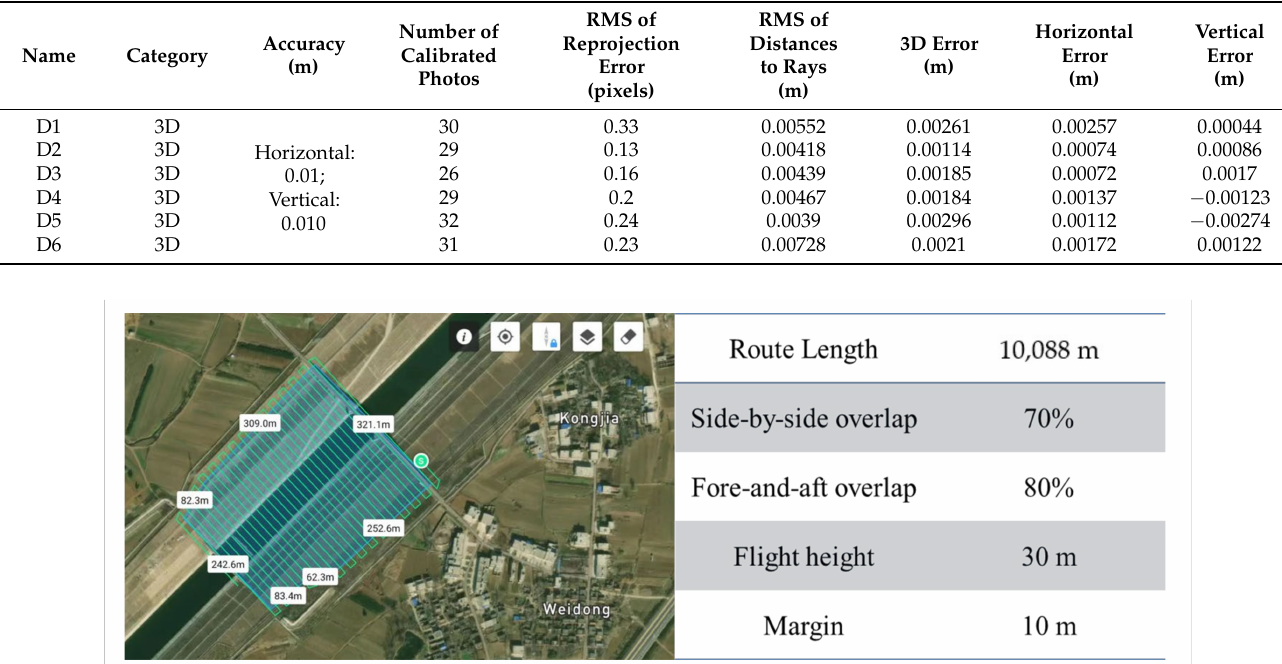
Figure 4. UAV route planning and basic parameter-setting